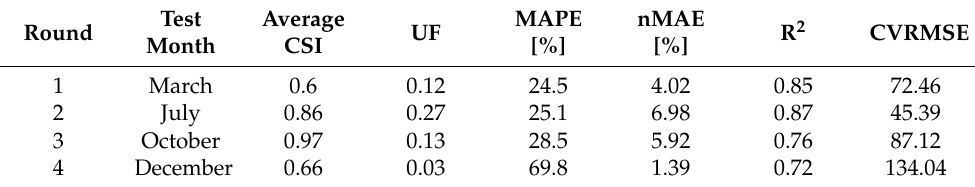
Table 7. Solar forecasting results for the 4 weeks of different test